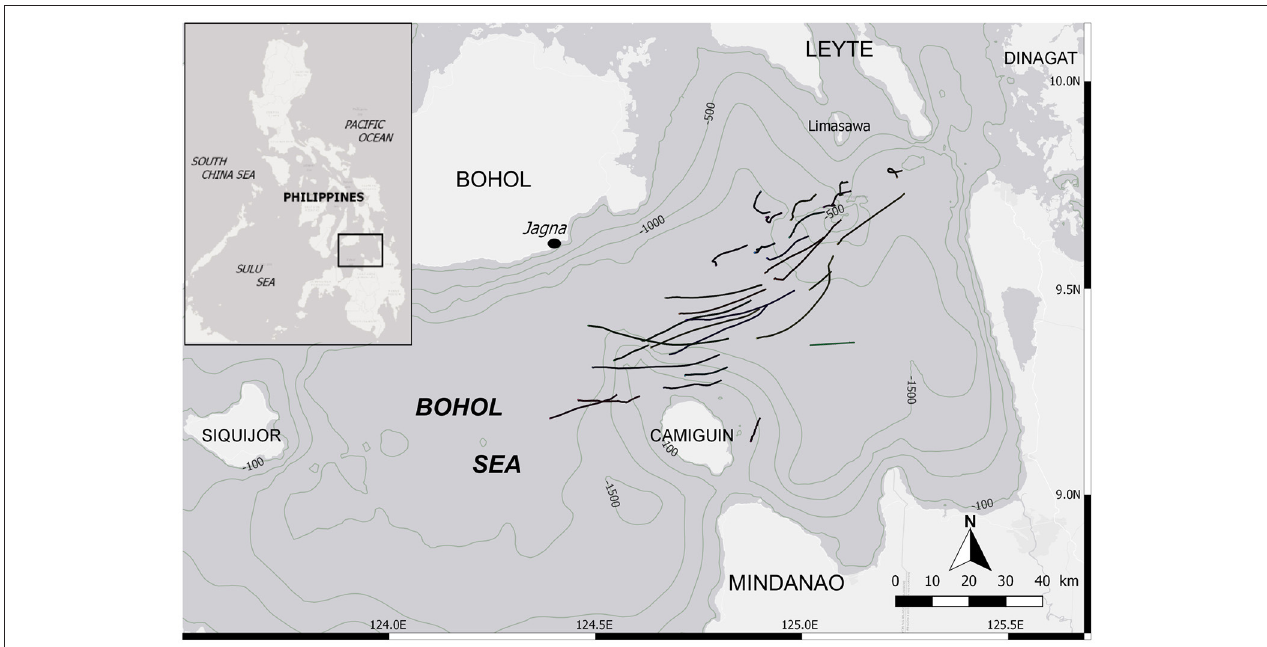
FIGURE 1 | Location of the landing site and the fishing grounds within the Bohol Sea, Philippines. Black lines depict tracks from mobulid fishing boats while their drift net was deployed ( n = 30). It is not exhaustive, but indicative of the fishing grounds.